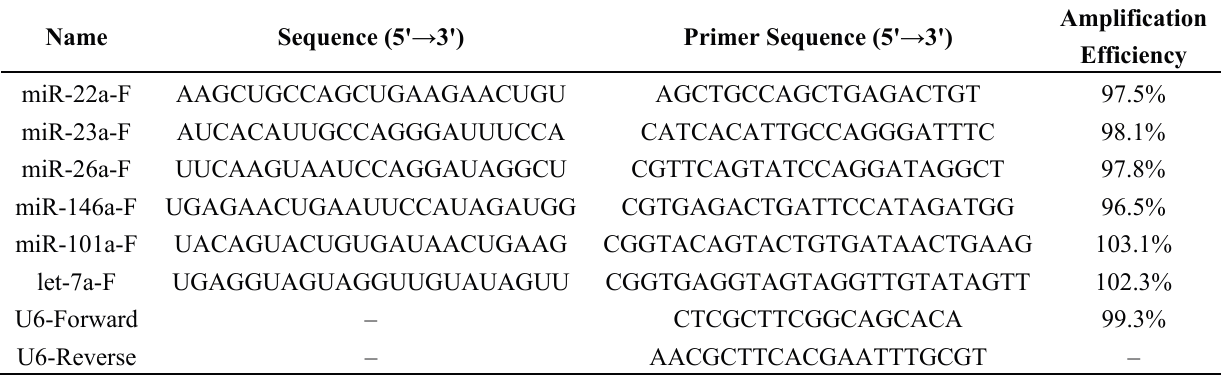
Table 1. Sequence and primer information for seven selected candidate reference